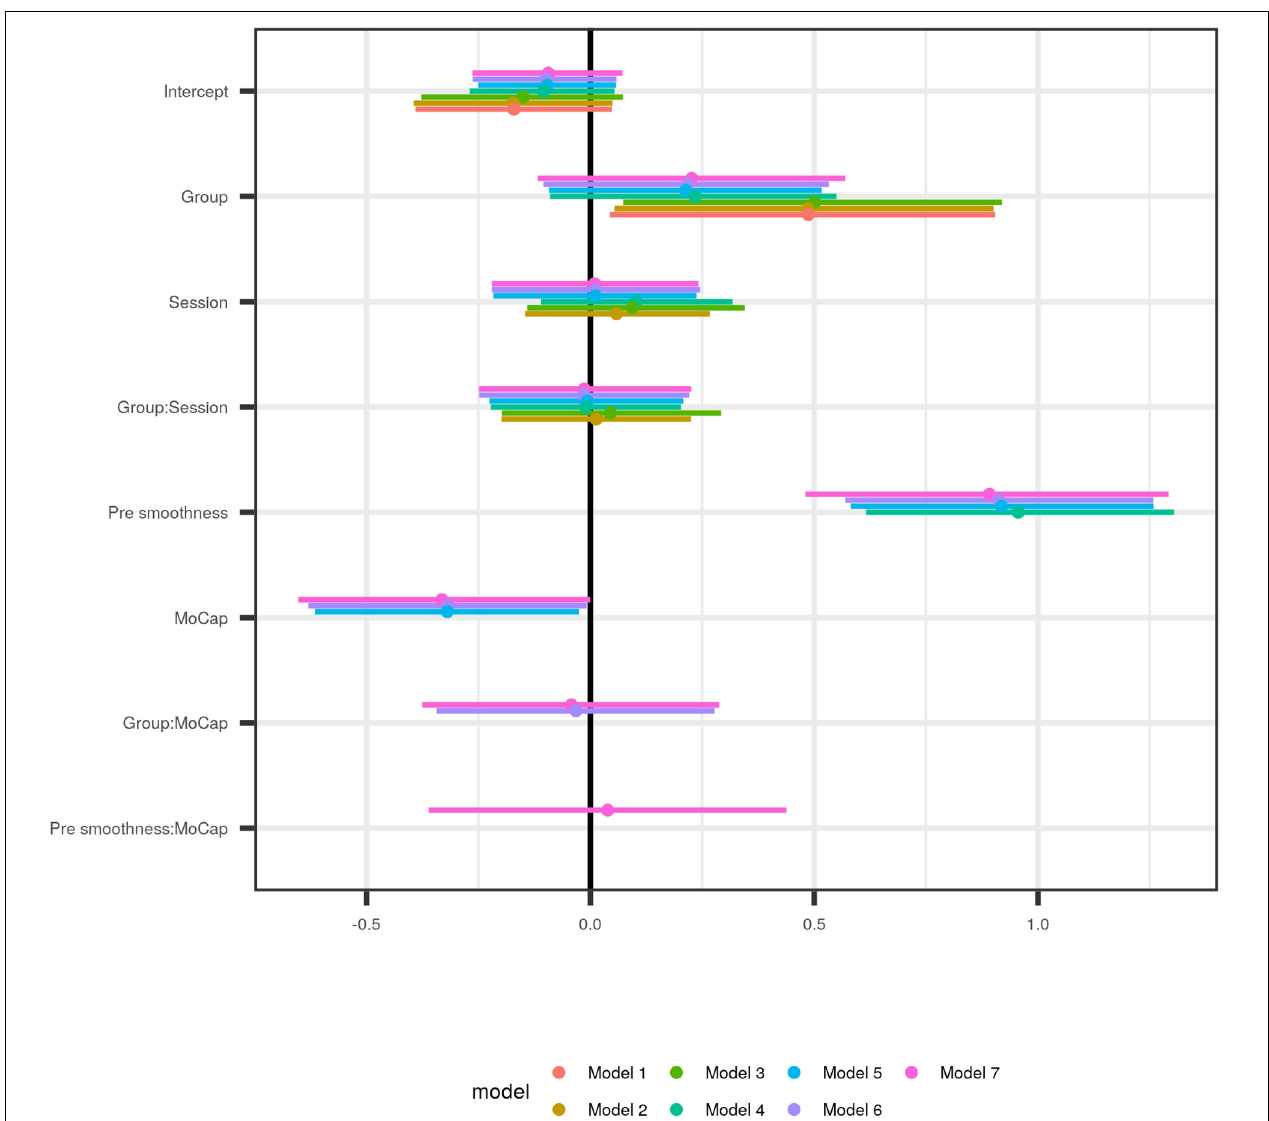
FIGURE 4 | Comparison of population parameters as estimated by models of increasing complexity, starting with the most simple one (#1), which modeled the outcome as the result of Group, and hence only has two parameters (Intercept and Group; see Table 2 for a numerical representation of the data). Model 2 additionally employed the time factor (Session) as explanatory variable, and its interaction with Group, and thus has two further parameter estimates, and so forth. The first three models do not change considerably, only the addition of pre-intervention movement smoothness pre smoothness as covariate in model 4 moves the Group estimate closer to zero. In model 5, with the motion capturing system added as covariate (MoCap), the Group estimate does not change much although the MoCap effect is